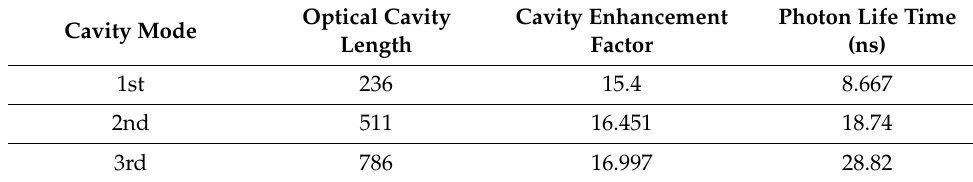
Figure 8. Plots of stopband width and bottom mirror peak reflectance versus refractive index contrast. Table 3. Cavity characteristics of the device with three periods of DBR3 at 550